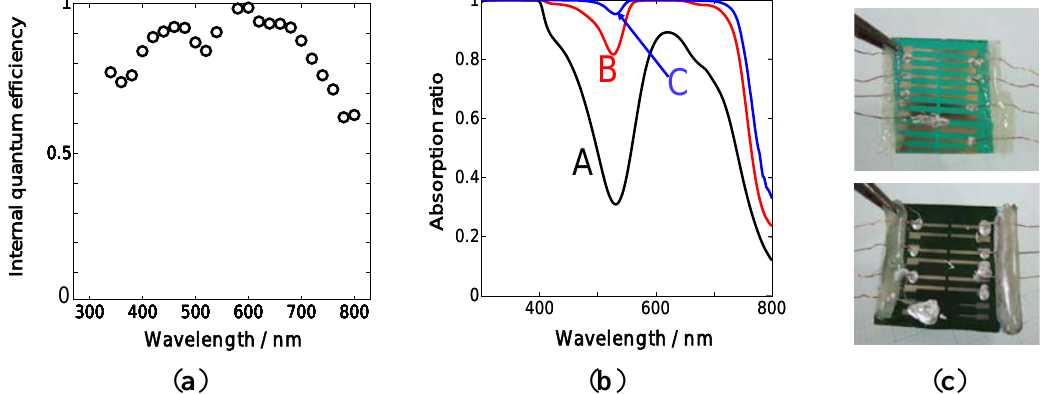
Figure 9. ( a ) Spectral dependence of the internal quantum efficiency for a cell with X = 960 nm; ( b ) Spectral dependences of the light absorption ratio of cells with X = 180 nm (curve A), 600 nm (curve B), and 960 nm (curve C); ( c ) Photograph of cells with X = 180 nm (top) and 960 nm